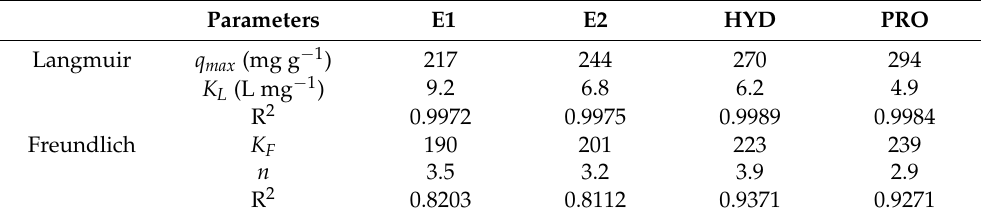
Table 6. Langmuir and Freundlich adsorption models and parameters investigated in the study. Parameters